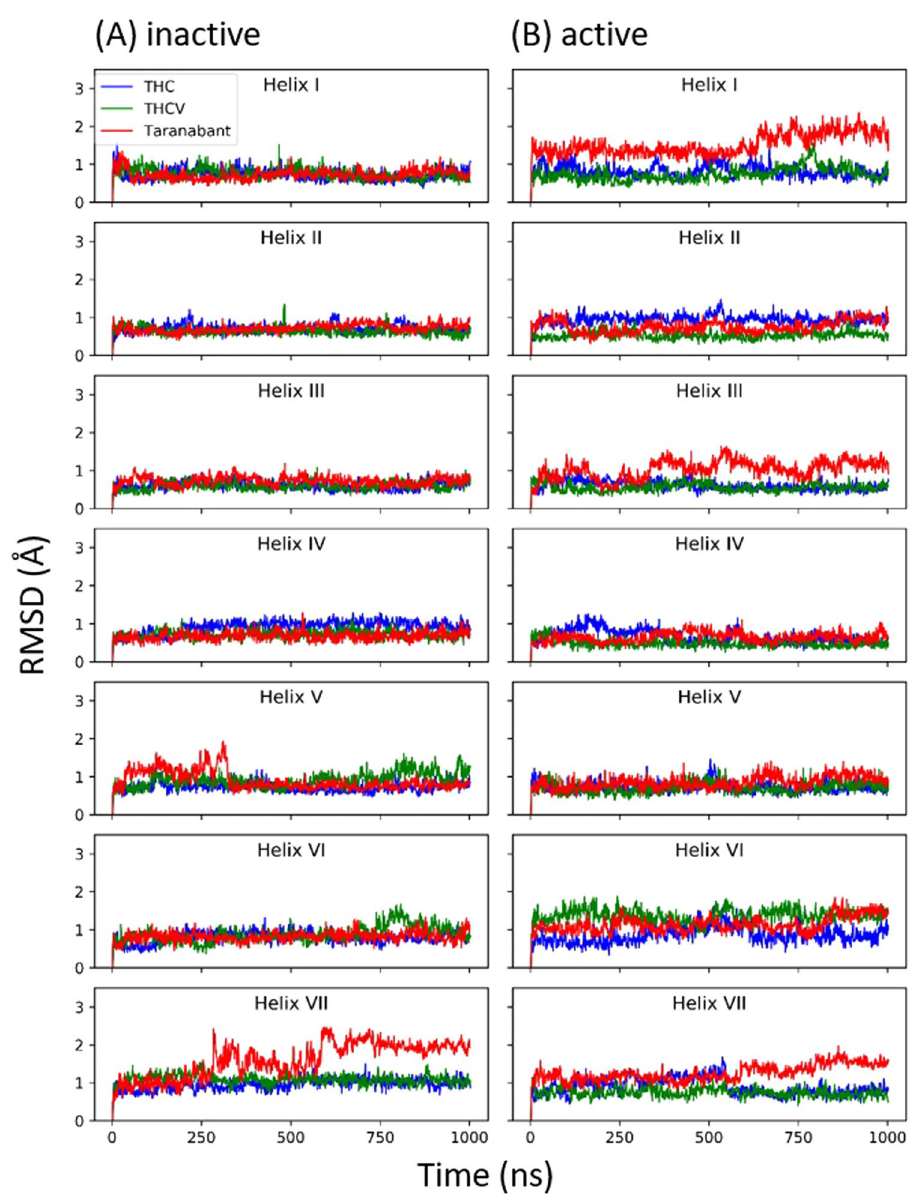
Figure 5. The RMSD values of each helix. The RSMD of each helix (helix I to helix VII) for ( A ) inactive and ( B ) active conformations of CB1 structures were calculated against their initial